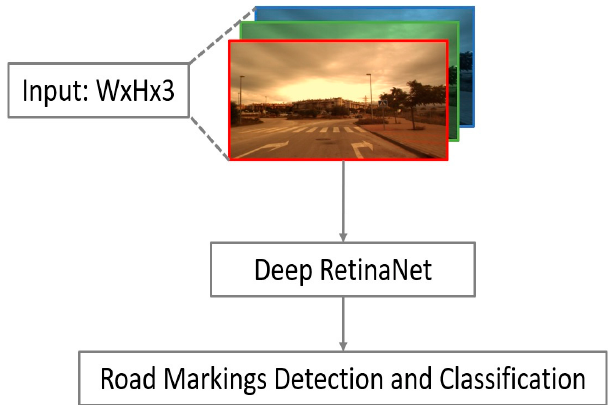
Figure 3. Proposed method for the detection and classification of road markings based on deep